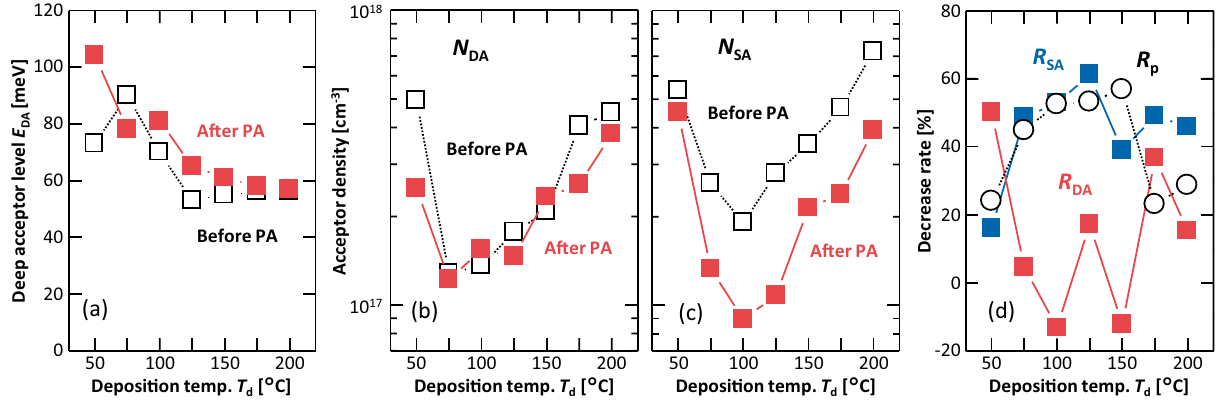
Figure 5. Analyses of the acceptors in the Ge layers before and after PA as a function of T d . ( a ) Deep acceptor level ( E DA ). Densities of ( b ) deep acceptor ( N DA ) and ( c ) shallow acceptor ( N SA ) layers. ( d ) Decrease rates of N DA , N SA , and p ( R DA , R SA , and R p ,